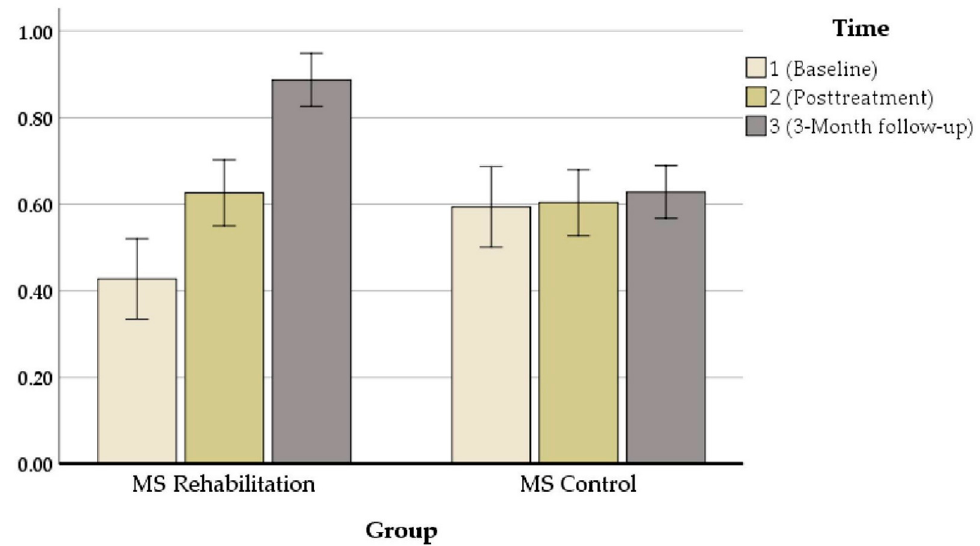
Figure 5. Composite attention performance (z-scores) in the ICRP intervention group and control group at baseline and posttreatment.